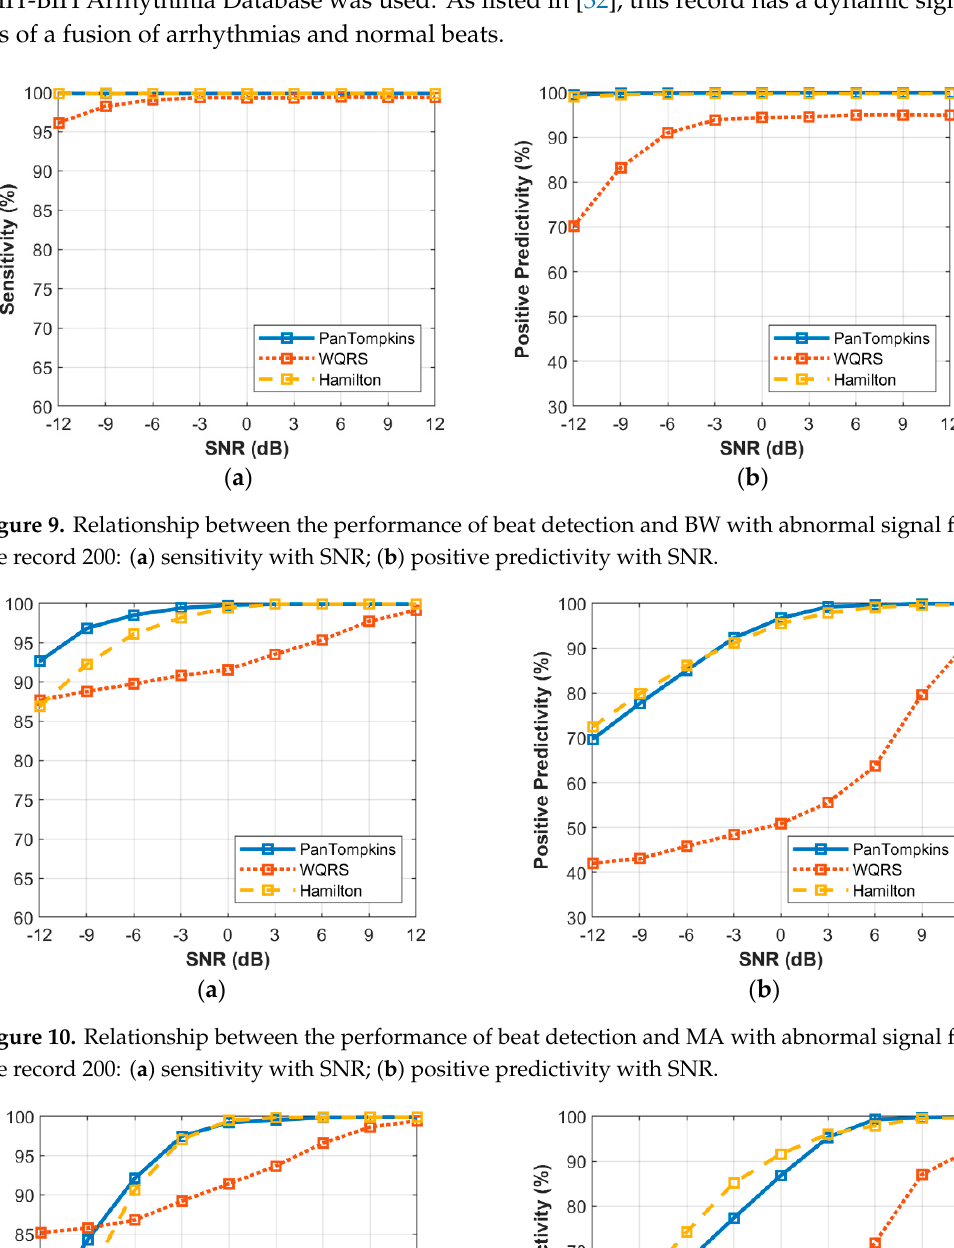
( b ) Figure 8. Relationship between the performance of beat detection and EM artefact for the record 100: ( a ) sensitivity with SNR; ( b ) positive predictivity with SNR. 3.5. Effect of Beat Detector Performance on Noisy Abnormal Signal of Record 200 The effect of a heartbeat detector on different levels of noise in the ECG signal that consisted of both abnormal or arrhythmia beats was determined. The simulated signals that contaminated with BW, MA and EM were used to evaluate the effects of detection on the intensity of the noise signal. Figures 9–11 demonstrate the relationship between the performance of beat detection and the level of noise. To evaluate the effects of noise contamination on arrhythmia signal, the record number 200